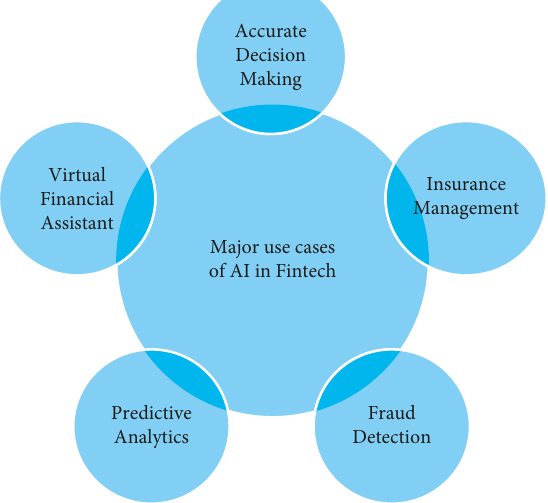
Figure 6: Application of proposed research in different fields (adapted from Moritz